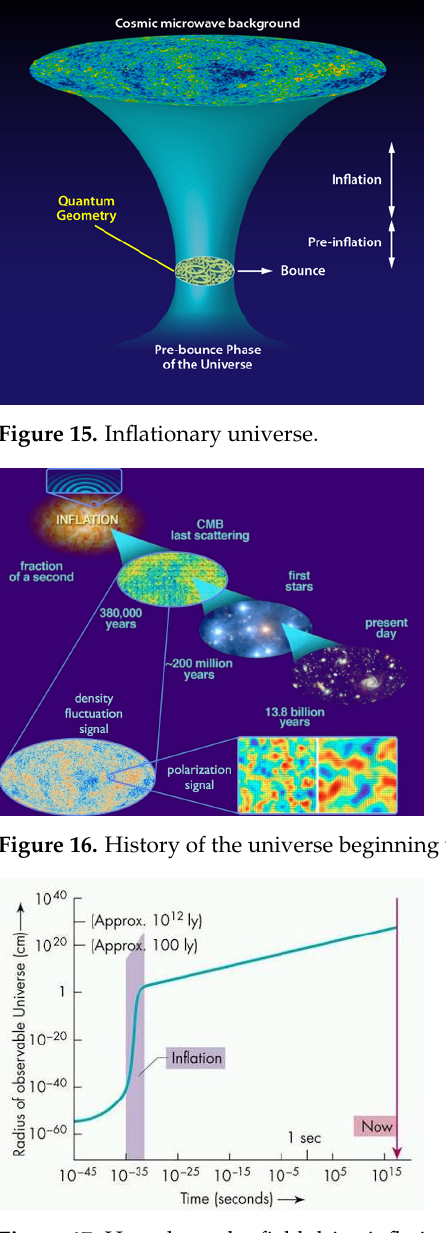
Figure 17. How the scalar field drive inflationary